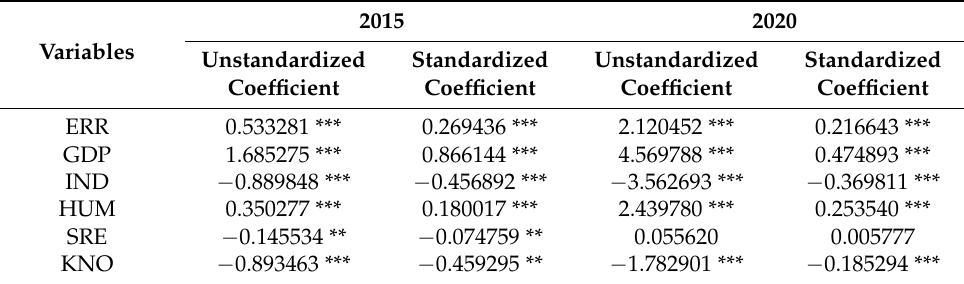
Table 3. QAP regression of influencing factors of green technology transfer in YRD.